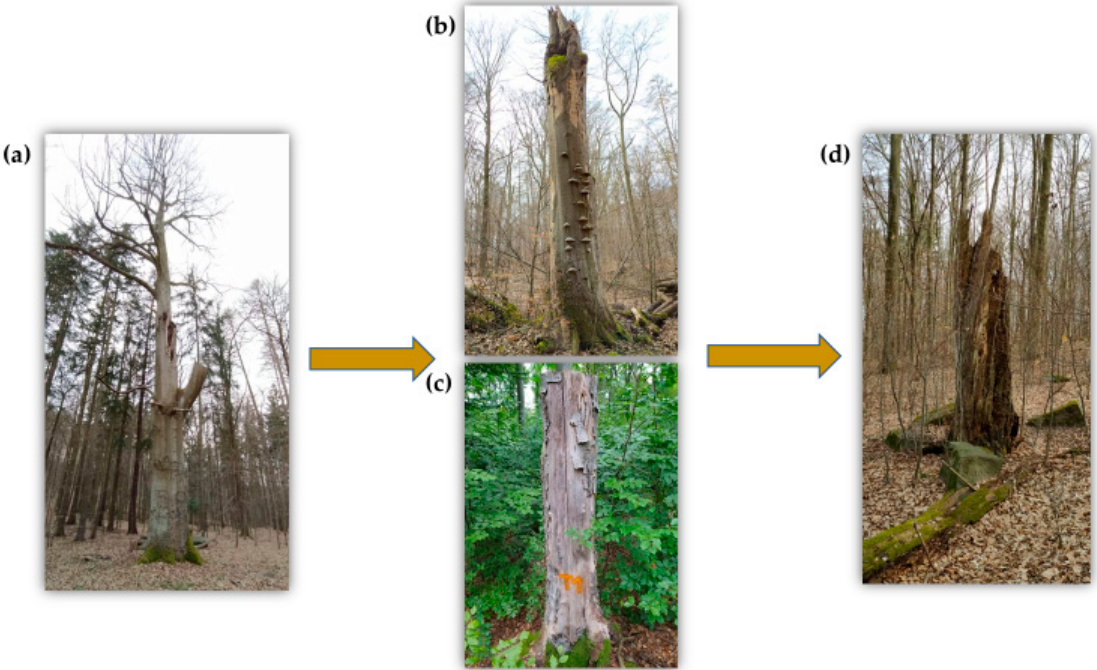
Figure 1. Development of a veteran tree. ( a ) Solitary tree, which is slowly approaching the limit of physical age and creates a variety of microhabitats. ( b ) The snags are very valuable for saproxylic beetles. ( c ) The man-made snags (high stumps) are a suitable substitute in places where trees cannot be left to develop spontaneously. ( d ) Very advanced stage of decomposition process of the snags.